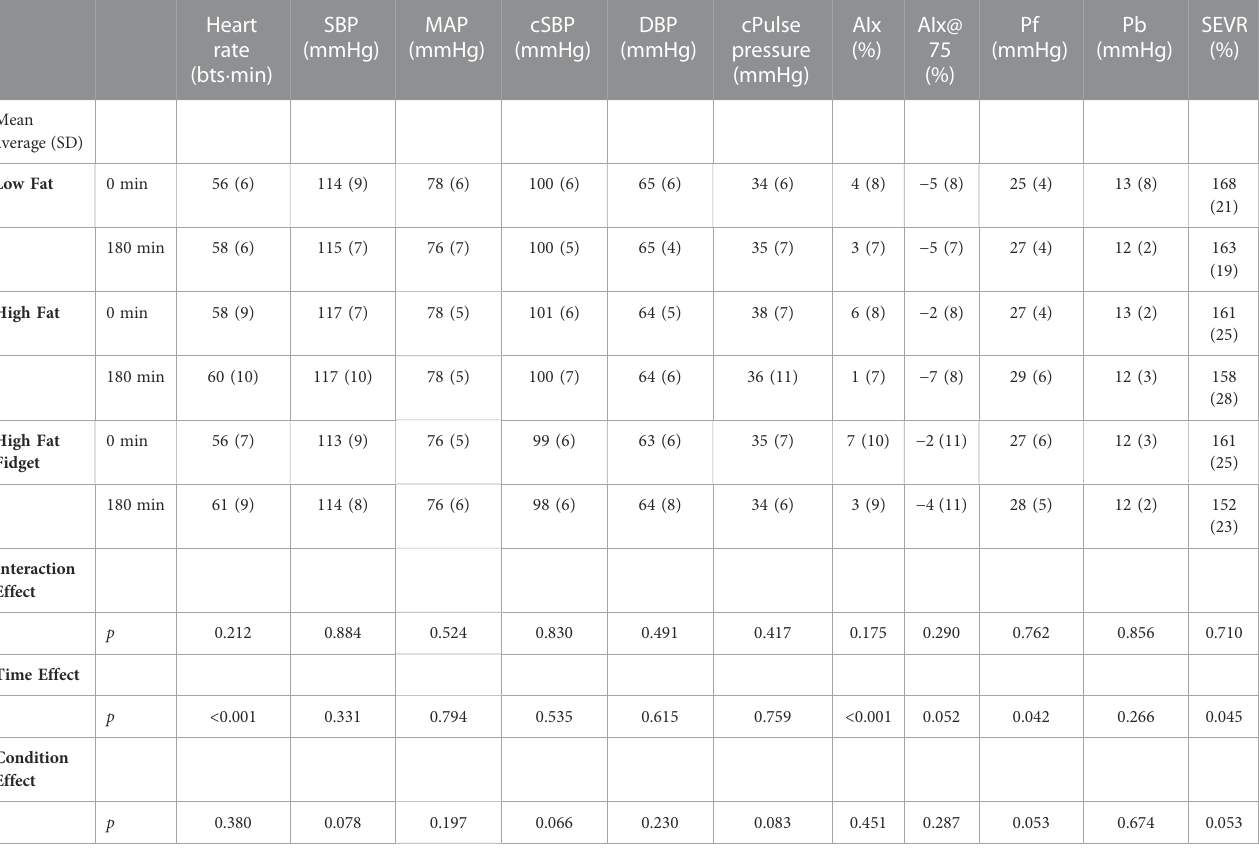
TABLE4Mean(±SD)interactionandmaineffectsforallpulsewaveanalysismeasuresassessedpreandpostlowfat,highfatandhighfat fi dgetingsittingtrials( n